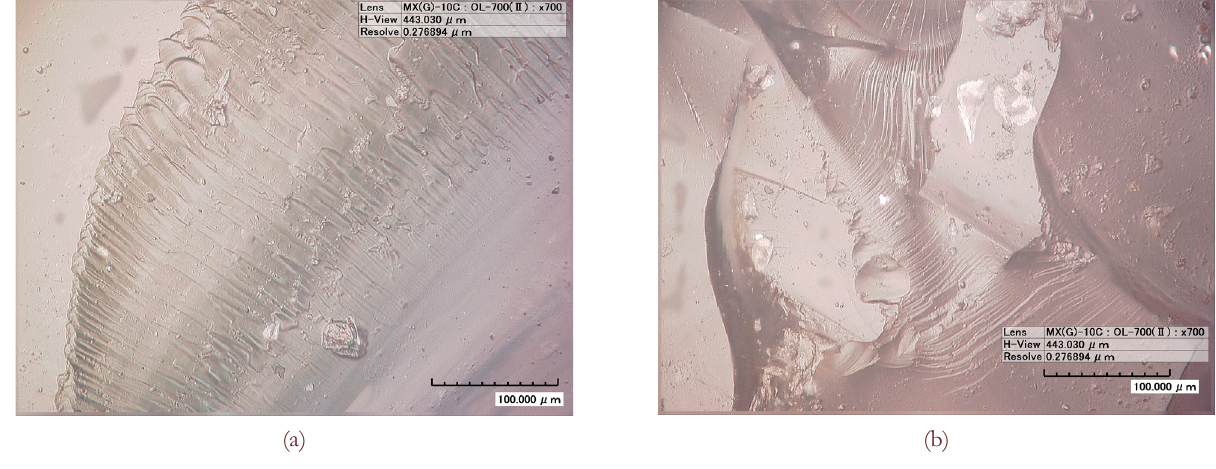
Figure 14: Fracture surface of quartz. Optical